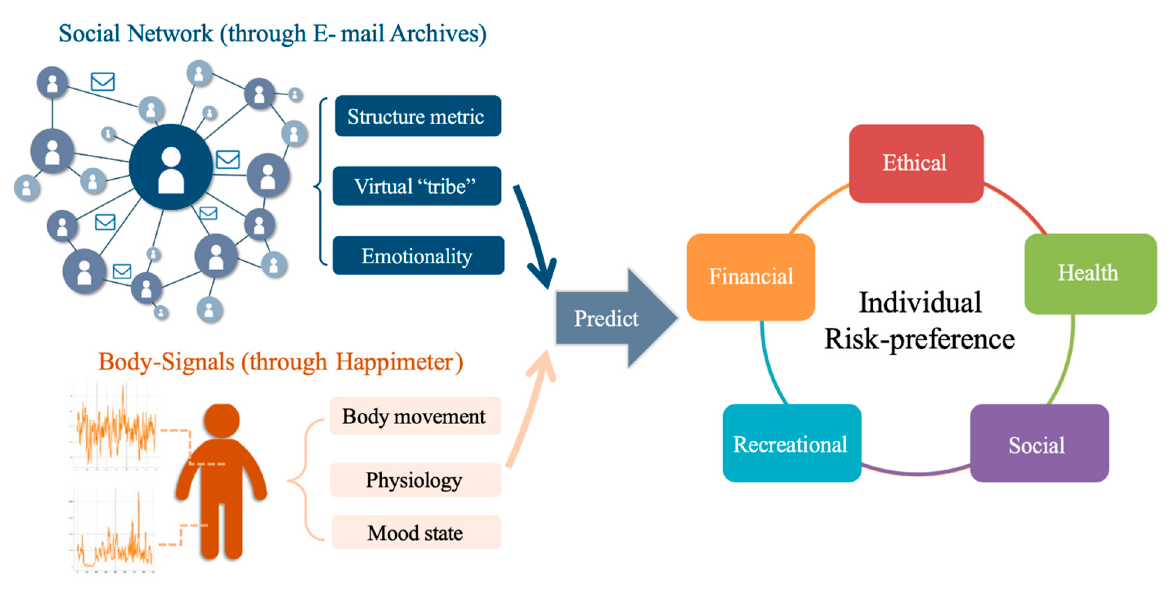
Figure 1. Theoretical framework. In this work we conduct two different case studies. On the one hand, a social network through e-mail archives is studied by analyzing structural metrics, virtual features, and emotionality. On the other hand, body-signal data are collected by using the Happimeter system. We then used both data separately to predict each person's risk-preference through the DOSPERT survey [32,33], in five specific domains.